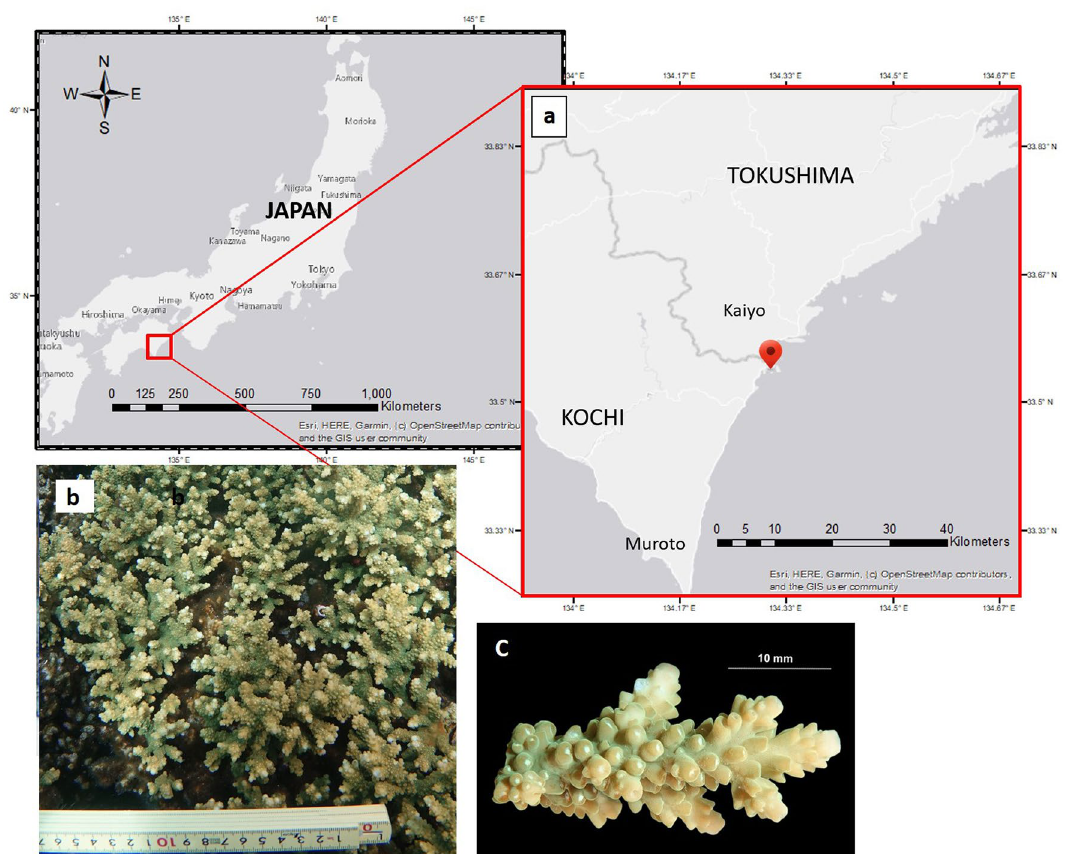
Figure 6. Map showing the location from where Acropora pruinosa gametes were obtained and used for artificial fertilization ( a ). The coral colony which released the egg-sperm bundles ( b ). A branch from the colony ( c ). Maps were generated using ArcMap 10.3 (https:// deskt op. arcgis. com/ en/